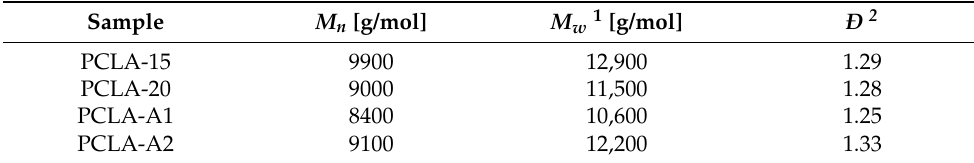
Table 3. The GPC measurement results for the samples synthesized under optimal conditions.